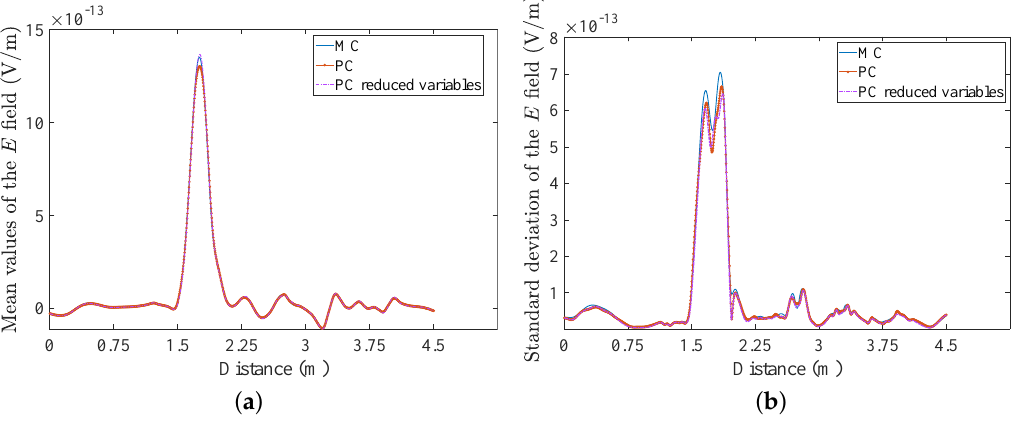
Figure 4. ( a ) Mean value and ( b ) standard deviation of the electric field for the second case of the 1D transmission-line